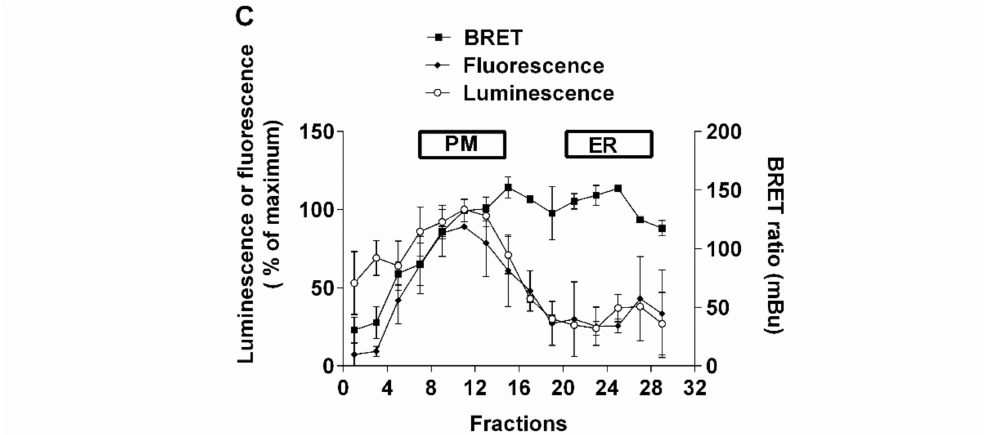
Figure 2. Characterization of H 3 R BRET signals. ( A ) The BRET donor saturation curve of H 3 R- RLuc-H 3 R-YFP ( (cid:4) ) is compared with that obtained with a control receptor ( ) (TAAR1-YFP). BRET (cid:35) saturation curves were generated by transient transfection of HEK 293 cells with a constant DNA amount of H 3 R-RLuc and increasing quantities of H 3 R-YFP or TAAR1-YFP. BRET, total luminescence, and total fluorescence were measured 48 h after transfection. BRET levels were plotted as a function of the ratio of the expression level of the YFP construct (quantitated by the total fluorescence of the cells) over the RLuc construct (quantitated by the luminescence of the cells) (fluorescence/luminescence). The results are representative of three independent experiments carried out in triplicate. The curve obtained for H 3 R-RLuc-H 3 R-YFP was best fitted with a non-linear regression equation assuming a single binding site (BRETmax = 144 ± 3 mBU), and the curve obtained for H 3 R-RLuc-TAAR1-YFP was best fitted with a linear regression equation. ( B ) To correlate fluorescence and luminescence levels with H 3 receptor densities, HEK 293 cells were transfected with increasing DNA concentrations of the H 3 R-Rluc or H 3 R-YFP constructs. Forty-eight hours after transfection, luminescence and fluorescence were measured, and H 3 R expression was determined by radioligand binding assay cells that were diluted in HBSS and distributed in 96-well microplates for luminescence or fluorescence measurements at a density of ~100,000 cells per well. To correlate the luminescence and fluorescence values with receptor densities, the specific number of [ 125 I]iodoproxyfan binding sites was deter- mined in the same cells. Luminescence (right, Y-axis) and fluorescence (left, Y-axis) were plotted against binding densities, and the linear regression of the data was performed using GraphPad Prism (inset, Figure 2B) as follows: H 3 R-Rluc: y = 26.3x + 467; H 3 R-YFP: y = 8.5x + 258). The BRET saturation curve presented in the inset was generated from the corrected ratio [H 3 R-YFP]/[H 3 R-Rluc], determined by transforming luminescence and fluorescence values measured for each data point into receptor densities using the equations described above. ( C ) Sub-cellular distribution of H 3 R dimers. HEK 293 cells were transfected with H 3 R-RLuc and H 3 R-YFP. Sub-cellular fractions were subjected to fluorescence/luminescence and BRET analysis. Means ± SEM of 6 determinations from 2 separate